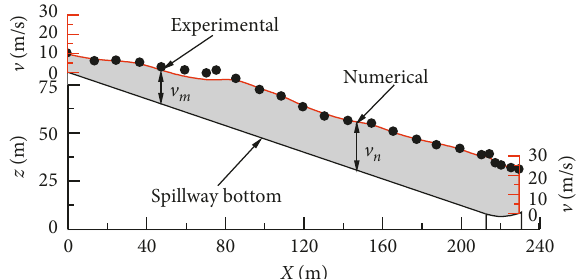
Figure 8: Mean velocity distribution along the chute centerline.